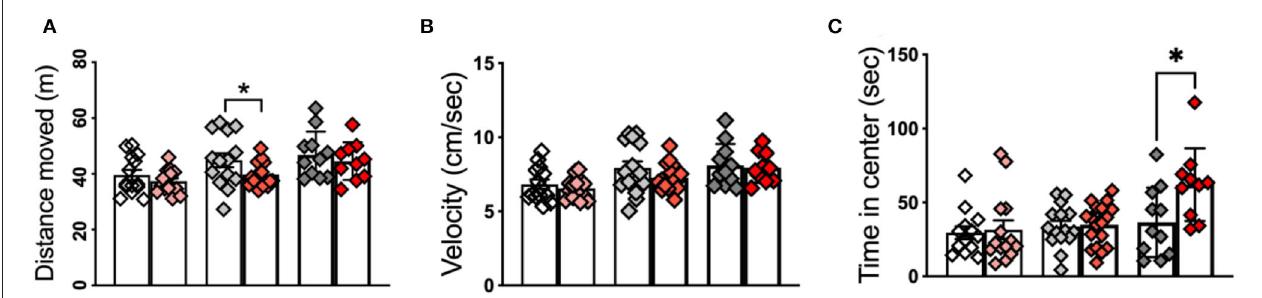
FIGURE 1 | Open-field test of 3-m, 6-m, and 12-m APPKI mice with age-matched WT mice. (A) Open-field test revealed a reduction in locomotor/exploratory activity in 6-m APPKI mice compared with age-matched WT. (B) No significant difference was observed in moving velocity in the APPKI mice at all three age points. (C) Open-field test revealed 12-m APPKI mice spent a longer time in the center area of the open-field arena. Data are presented as mean ± SEM; n = 10–20 mice per group. Data were analyzed using Student’s t -test between WT and APPKI group from the same time point. Significance was assumed when p < 0.05. * p <